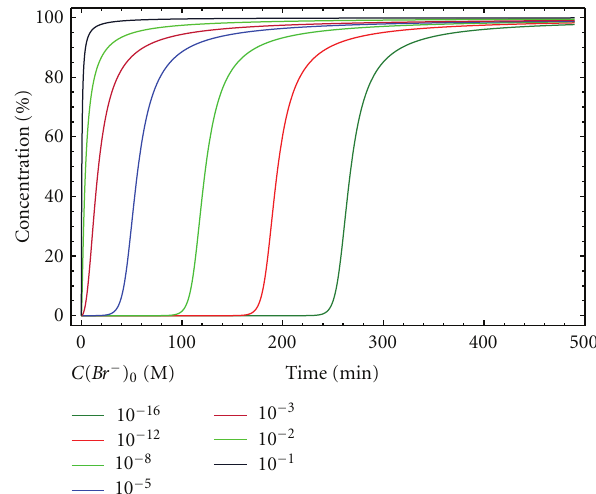
Figure 10: Concentration of the macrocycle D versus time, for di ff erent initial concentrations of Br − for kinetic model 5. [A] 0 = [B] 0 = 0.005 M, k 1 c = 4000 M − 2 min − 1 and k 2 c = 200 M − 1 min − 1